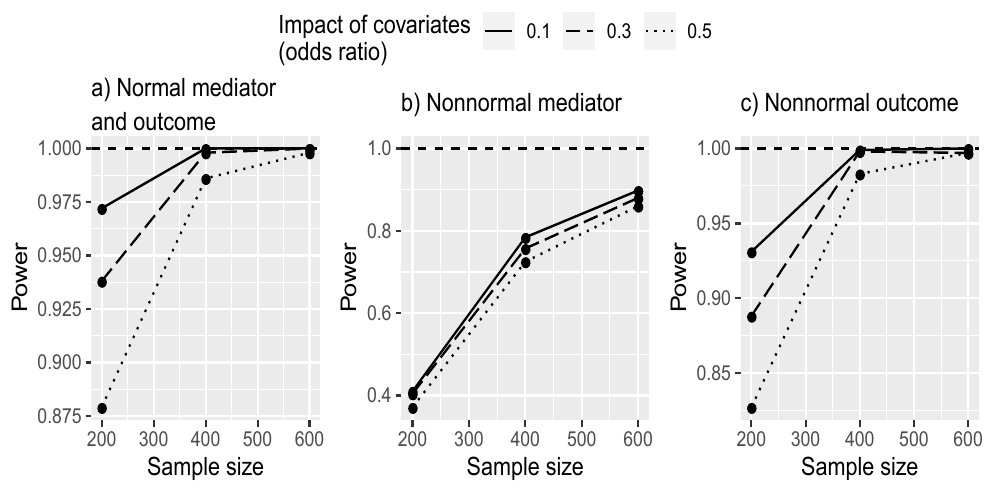
Figure 2: Statistical power of δ (1) Note. 1) True effect: δ (1) = 1 . 2) The results for ζ (0) are similar to the ones for δ (1) . Given the similarity, we present the results for ζ (0) in the